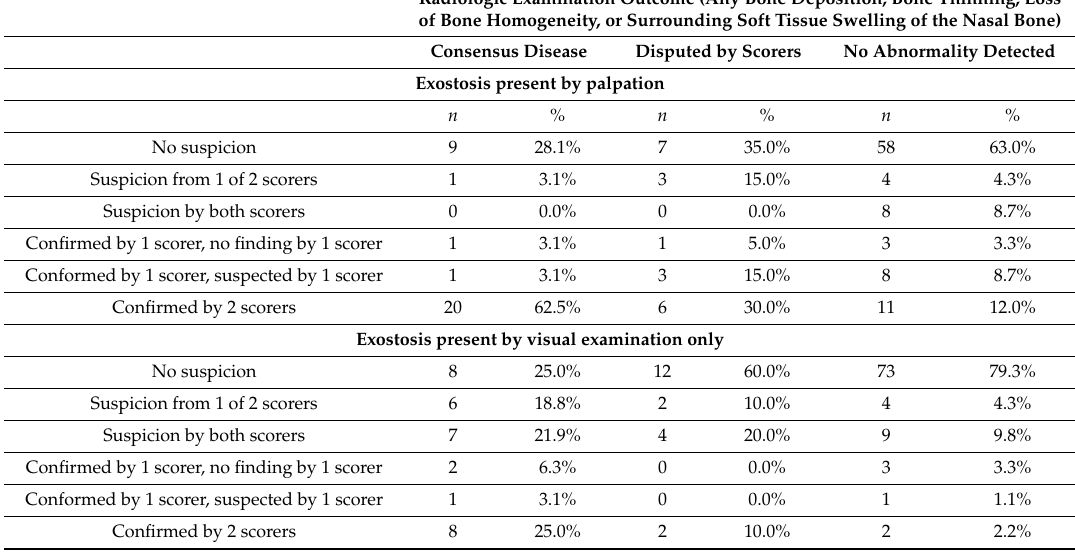
Table 7. Relationship between any radiographic lesion being noted and the exostosis physical examination findings of the mandibles of 144 horses.